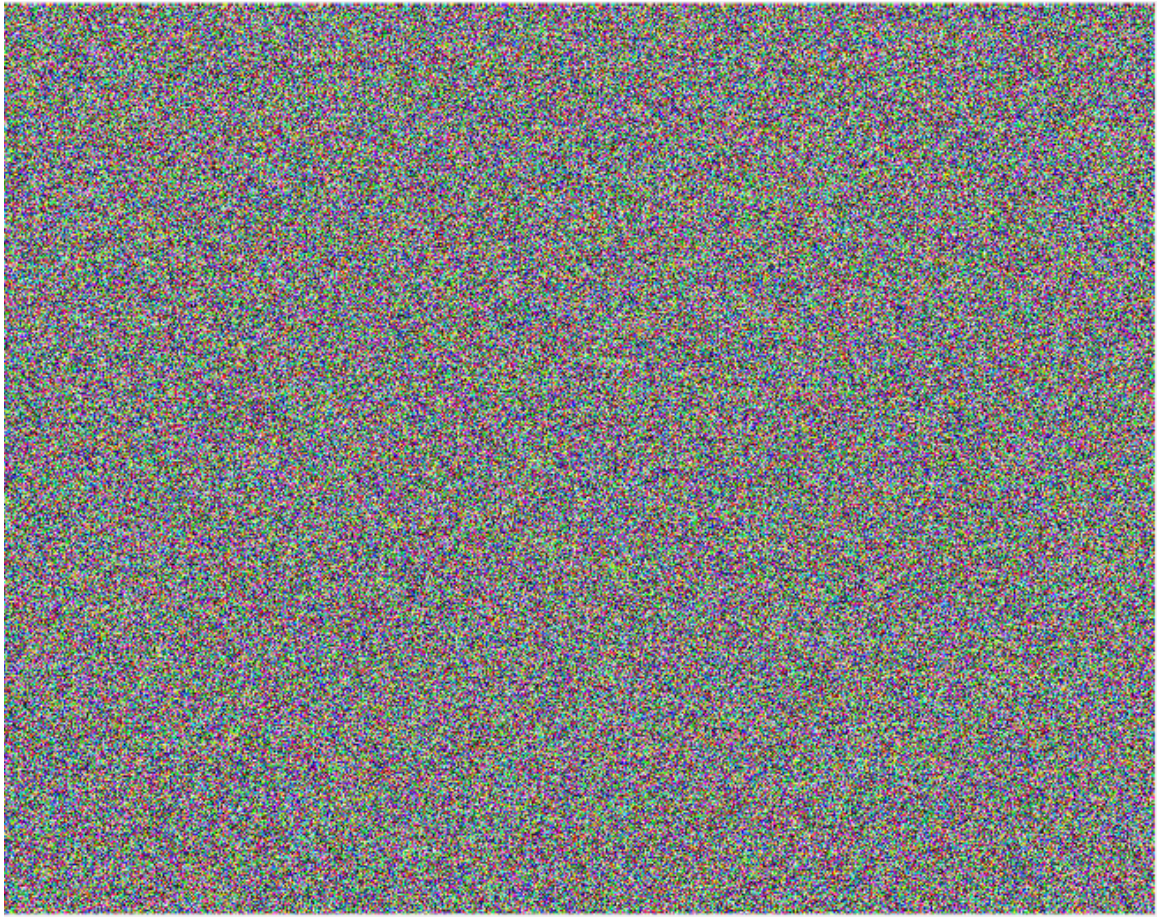
Figure 12. Ciphertext of the person walking